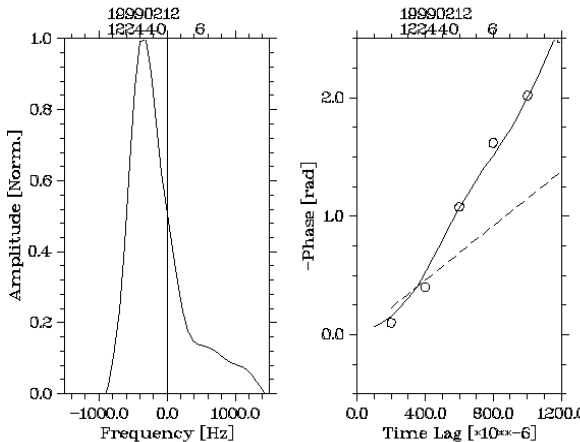
Fig. 3. (a) The backscattered power spectrum observed with